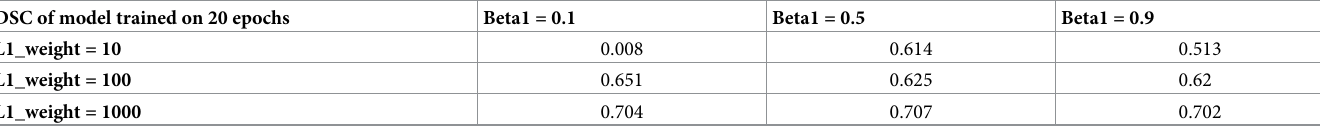
Table 2. Results of grid search for the combinations of beta1 and L1_weight in the model validation datasets. DSC of model trained on 20 epochs